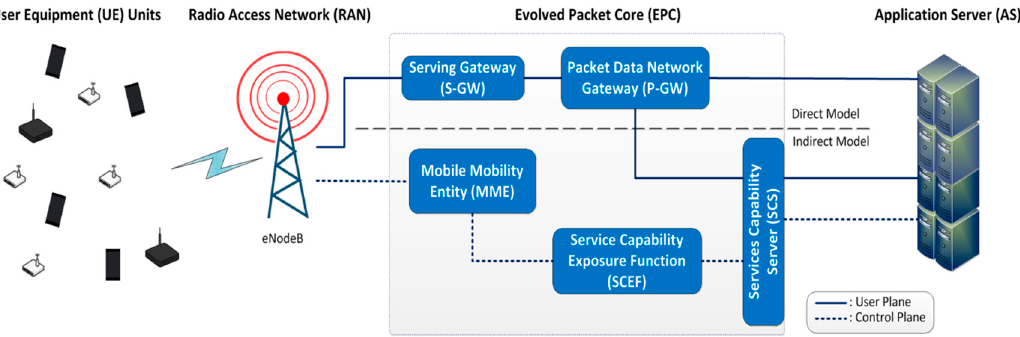
Figure 2. Simplified version of the radio access network (RAN) for NB ‐ IoT UEs and the evolved packet core (EPC).